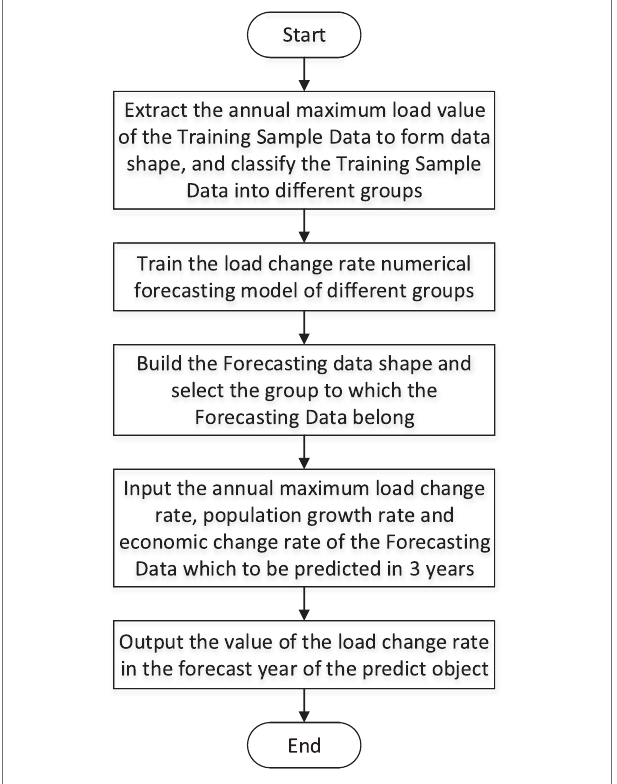
FIGURE 8 | The load change rate numerical forecasting link fl ow